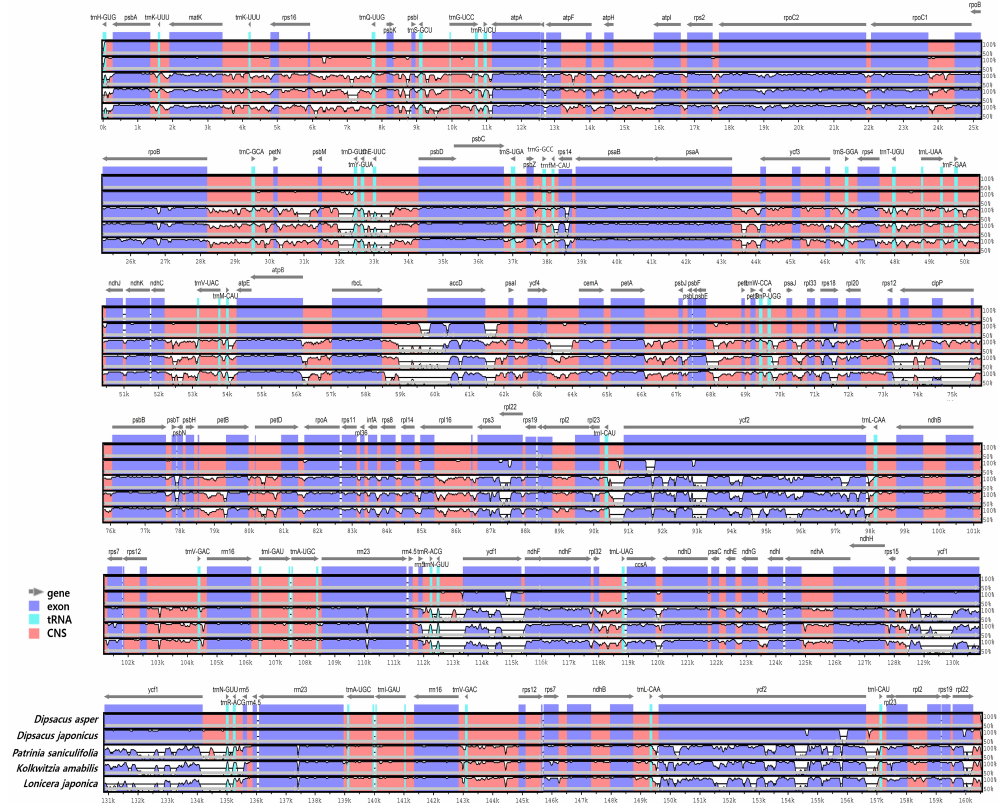
Figure 2. The comparative analysis of chloroplast genomes of species within the family Caprifoliaceae using mVISTA. Blue indicates conserved genes, light blue indicates tRNA and rRNA, red indicates conserved non-coding sequences (CNS), and white represents divergent regions. A cut-off of a 50% identity was used for the plots. The Y -axis represents 50–100%